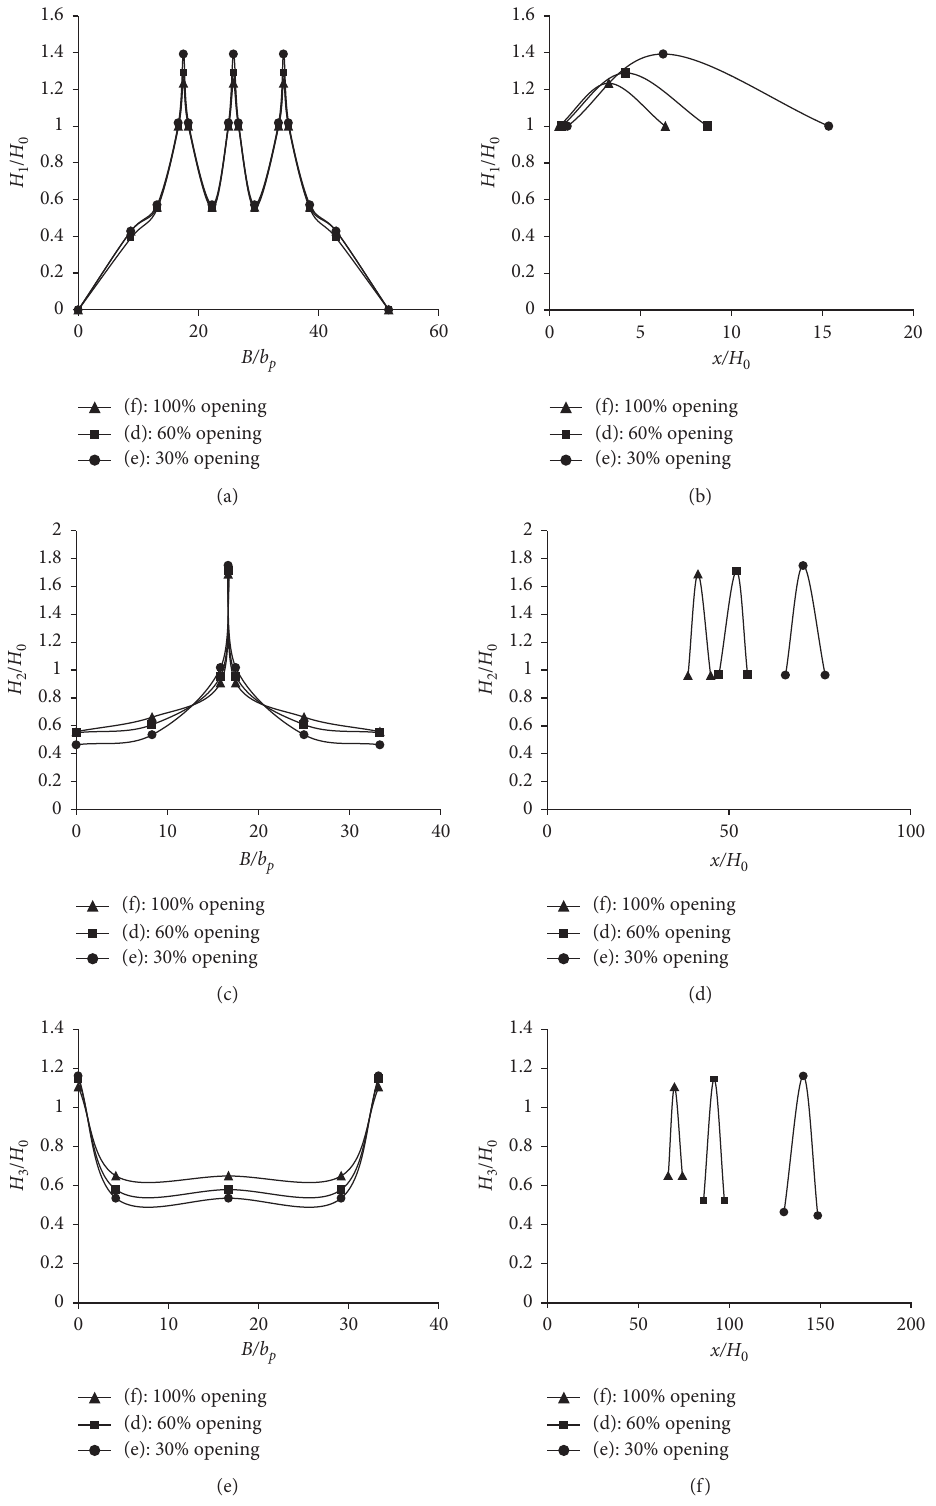
Figure 9: Longitudinal and transverse dimensionless profiles of waves for the four gates’ dimensionless relative to the velocity head in the form of openings 100%, 60%, and 30% with corresponding input c � ( p / ( V 2 /2 g )) . The horizontal axis also indicates the Froude numbers. The vertical axis represents the pressure p coefficient. In the control section, the pressure coefficient is longitudinal distance of the points from the pier beginning.